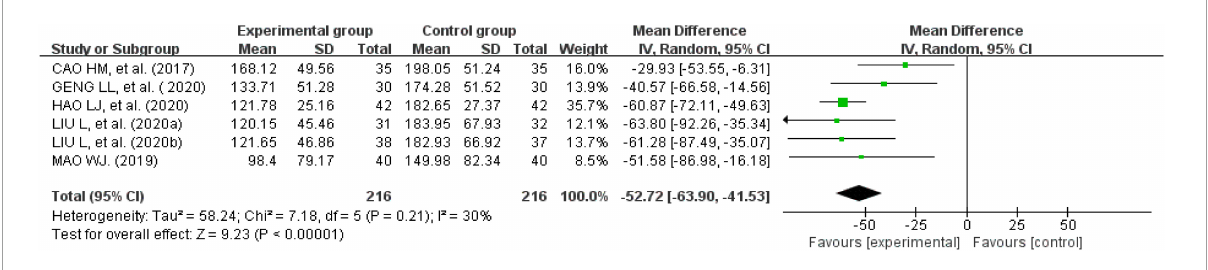
FIGURE8 Forest plot of the score on irritable bowel syndrome-severity scoring system score questionnaire.